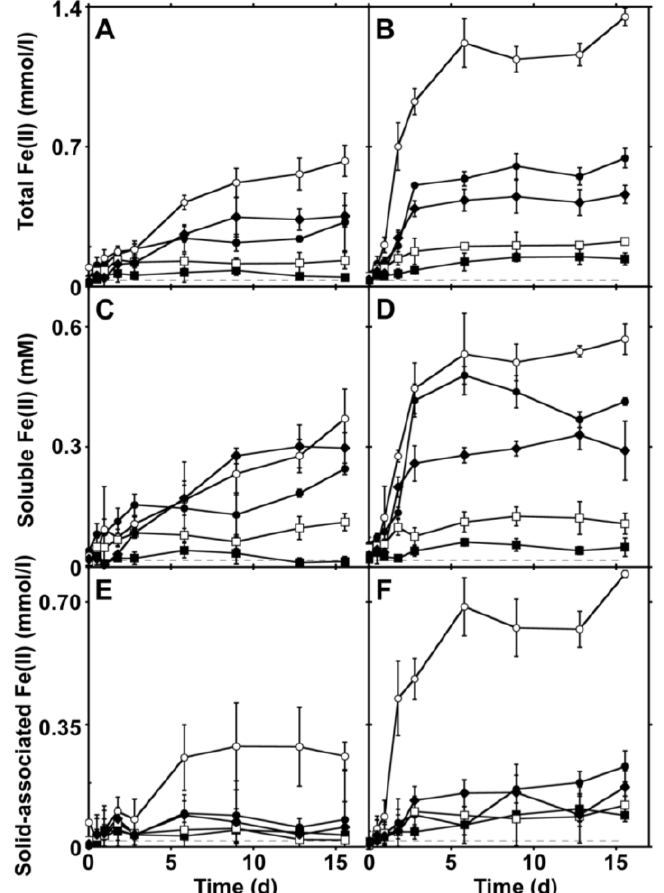
Figure 4. Total (0.5 M HCl-extractable) Fe(II) [( A ) and ( B )], soluble Fe(II) [( C ) and ( D )], and solid-associated Fe(II) [( E ) and ( F )] in incubations containing S. oneidensis MR-1 and BIF (●), canga (○), iron ore (■), material from HEM (□), and material from HEM (♦). spec lam Fe(II) concentrations in anthroquinone-2,6-disulfonate (AQDS)-free incubations are shown in panels ( A ), ( C ), and ( E ), and Fe(II) concentrations in AQDS-amended incubations are shown in panels ( B ), ( D ), and ( F ). Dashed lines represent respective Fe(II) concentrations in uninoculated incubations. Error bars represent one standard deviation.